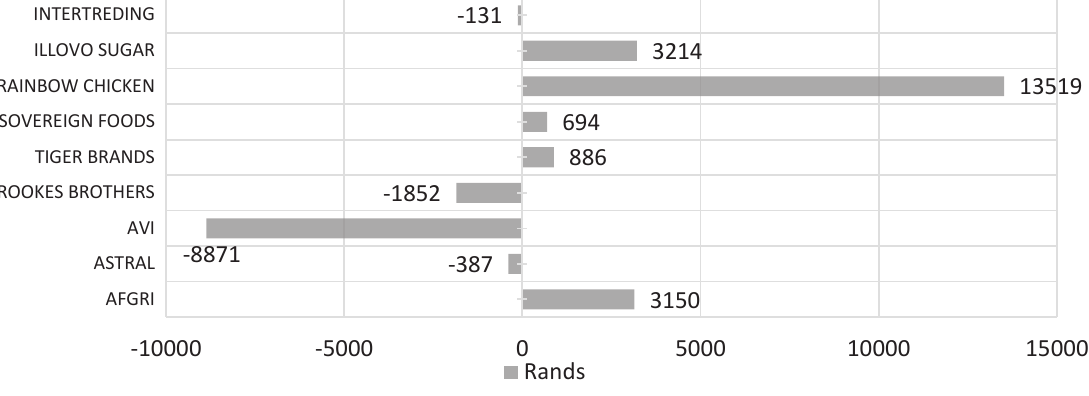
Figure 1. Increases and decreases in deferred tax expenses (Rand values in